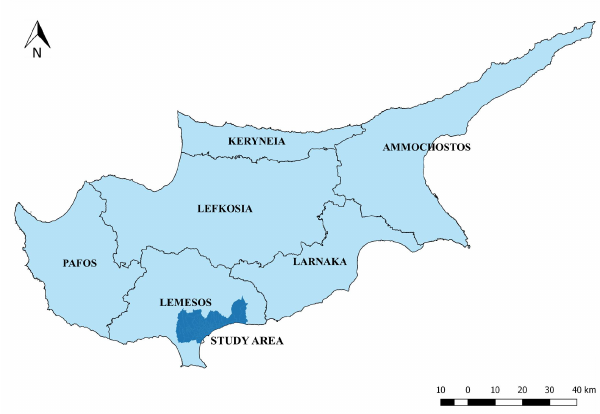
Figure 1. Cyprus and case study